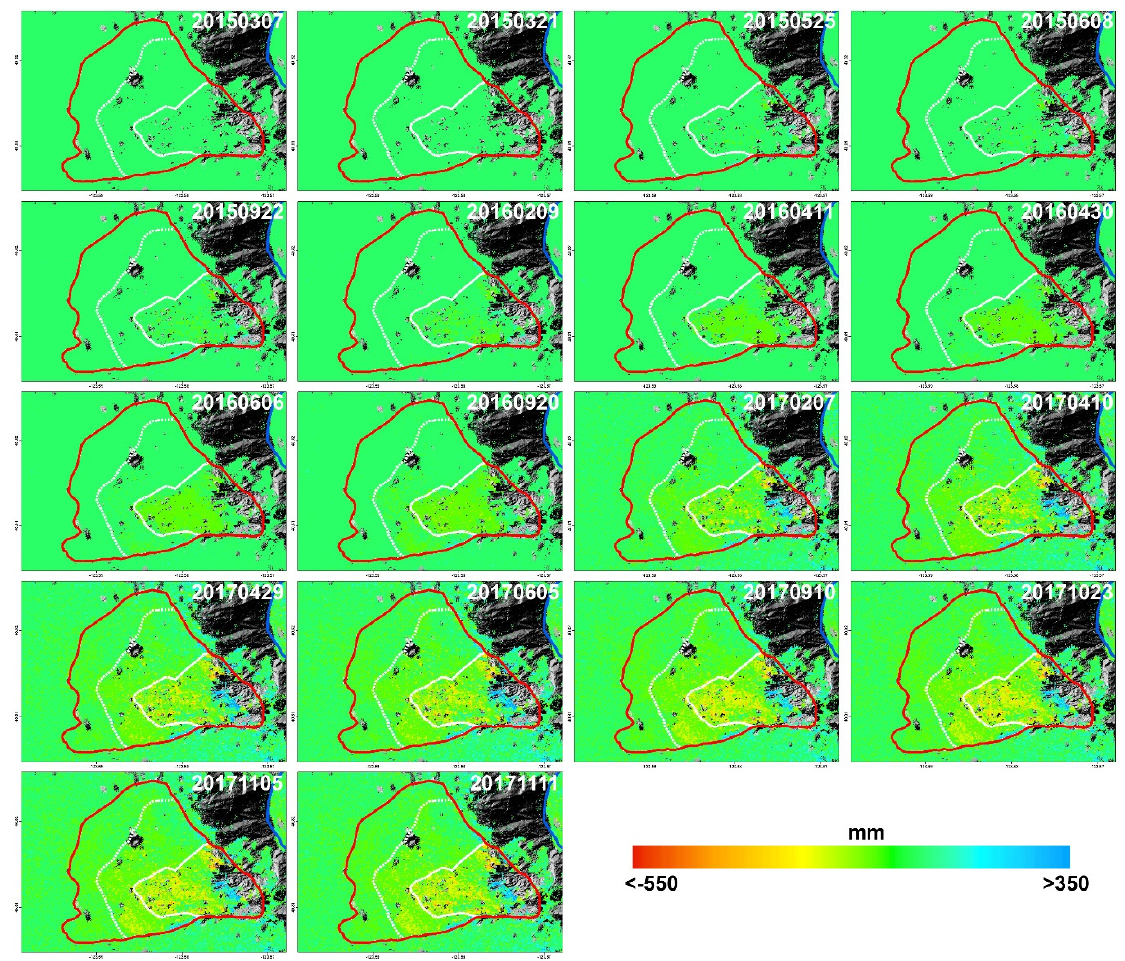
Figure 9. Cumulative vertical deformation from 7 March 2015 to 11 November 2017 inverted by using ascending and descending ALOS PALSAR-2 satellite datasets.